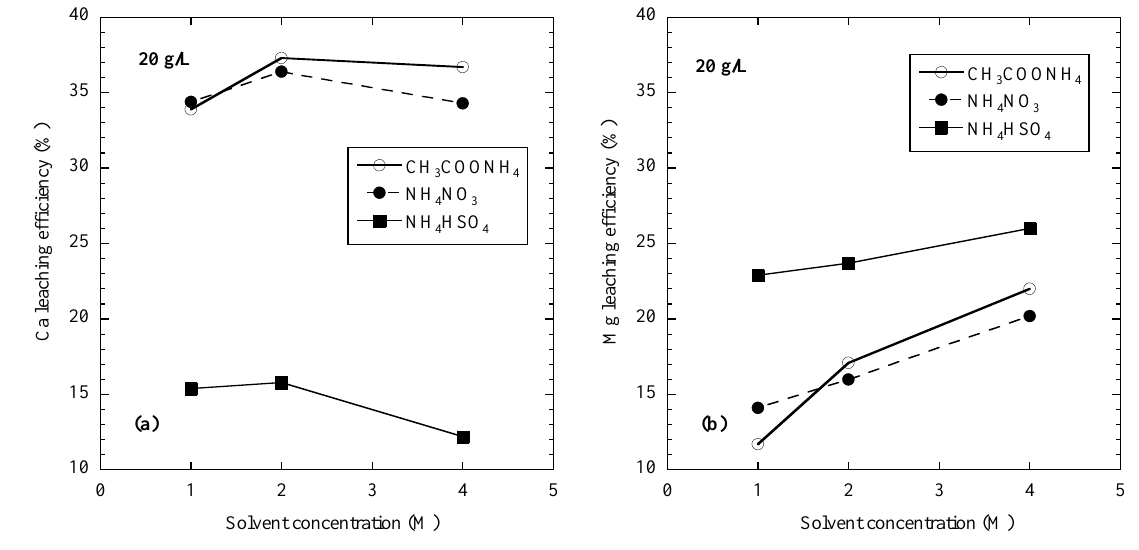
Figure 4. Ca and Mg-leaching efficiencies as a function of solvent concentration at the solid dosage of 20 g/L for waste slate